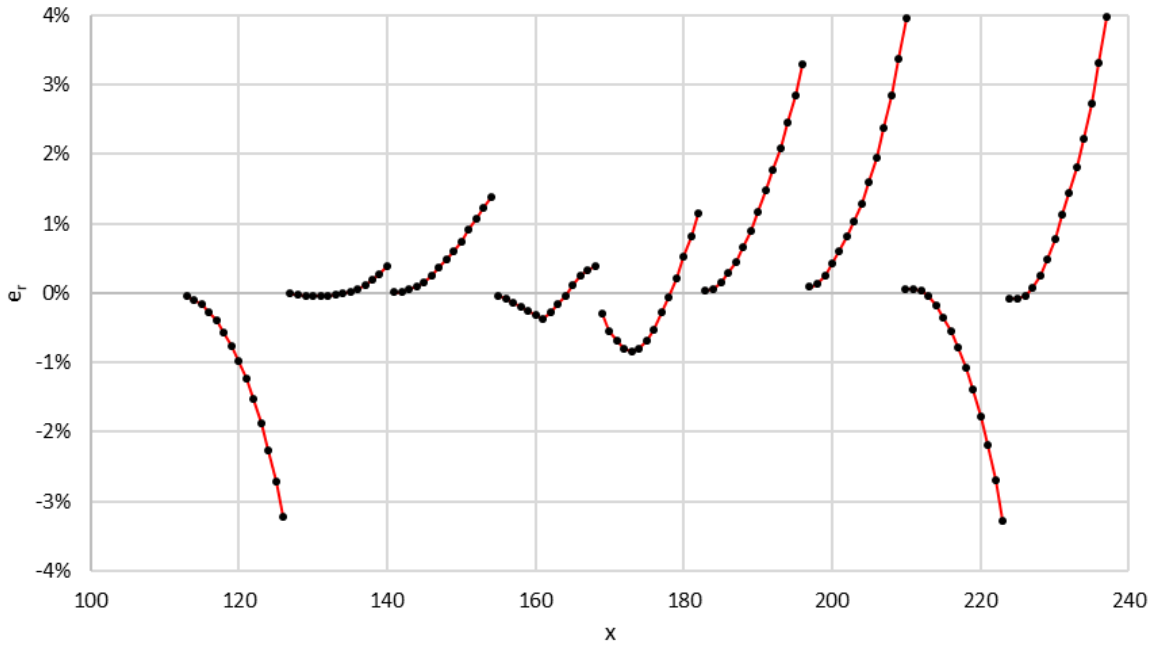
Figure 7. Relative standard errors for each of the nine predictor